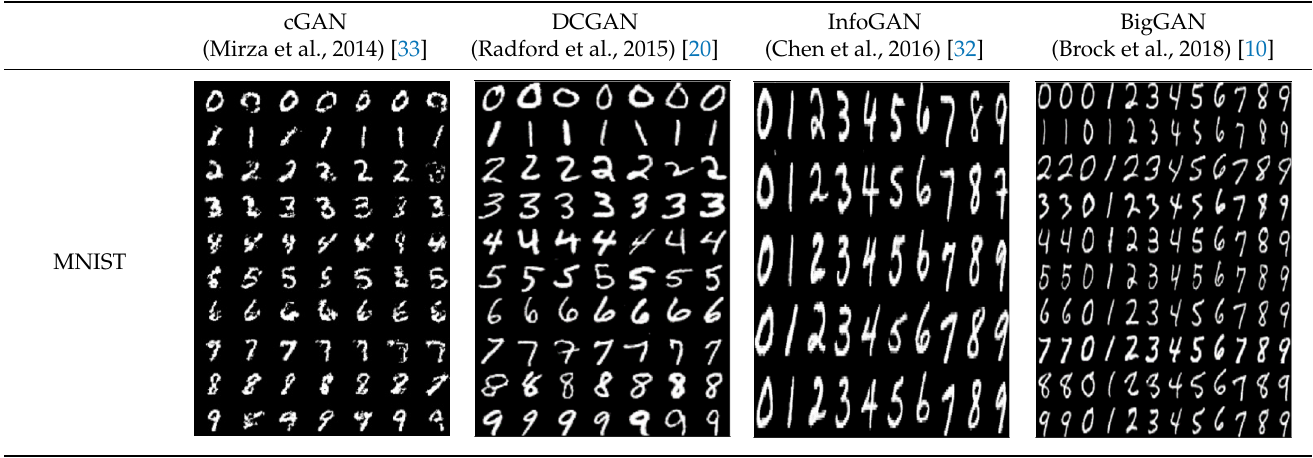
Table 1. Visual results of different models trained with the MNIST dataset. More results are presented in that paper.